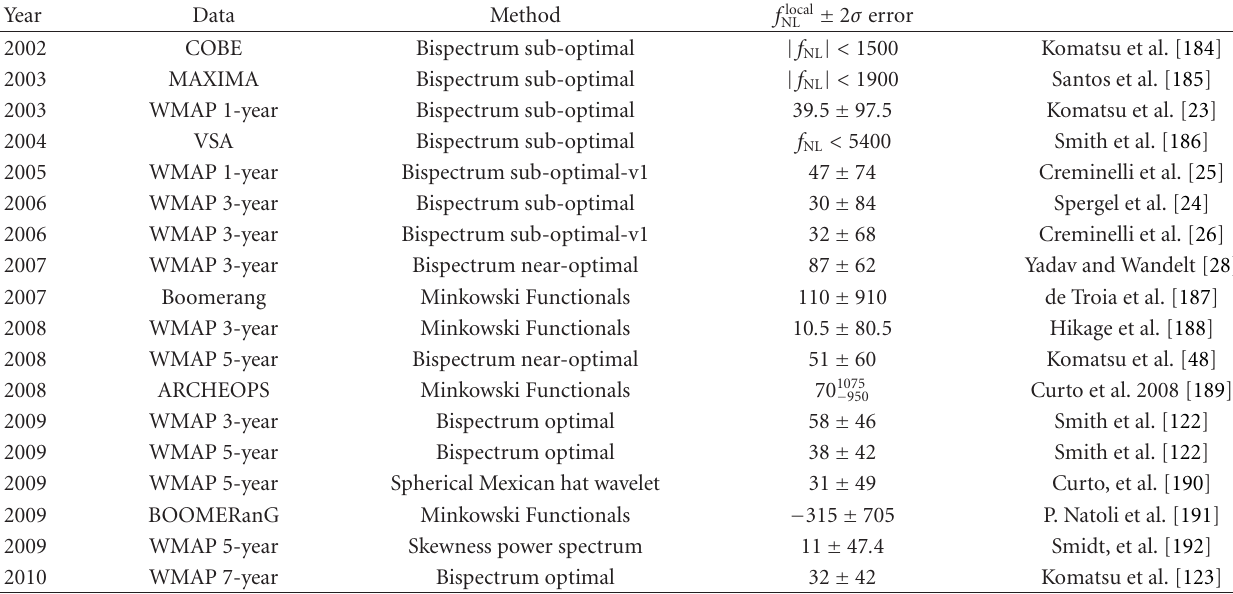
Table 2: Summary of constraints on local